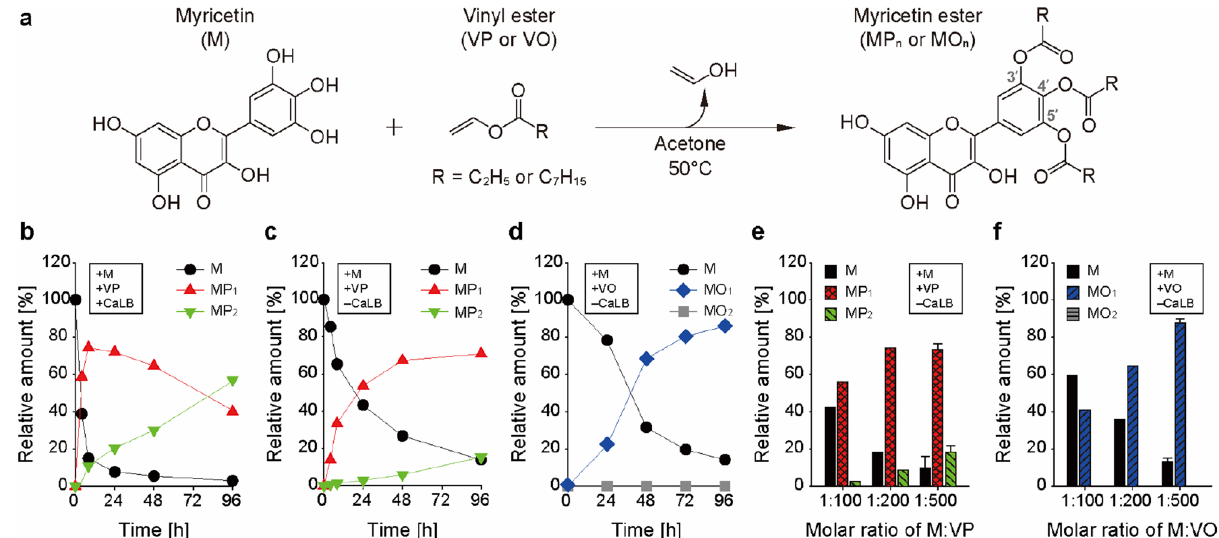
Figure 1. Synthesis of acyl myricetins in the presence and absence of an enzyme catalyst CaLB. ( a ) Schematic representation of acylation reaction of myricetin with vinyl ester [VP, vinyl propionate (R = C 2 H 5 ); VO, vinyl octanoate (R = C 7 H 15 )], resulting in acyl myricetins. The reactions were conducted by shaking with 700 rpm at 50 °C in acetone. Three carbon positions susceptible to acylation are indicated as gray color in myricetin ester structure. ( b – d ) Acylation profiles of myricetin. ( b ) Myricetin (0.3 mg·mL −1 ) was acylated at a molar ratio of 1:500 with VP in the presence of 20 mg·mL −1 CaLB. For spontaneous acylation in the absence of CaLB, VP ( c ) or VO ( d ) as an acyl group donor was used in a reaction adopting the same conditions as in ( b ). ( e , f ) Effects of molar ratio of myricetin-to-vinyl ester on acylation efficiency. The relative amounts of free, monoacyl-, and diacyl-myricetin were determined after propionylation ( e ) and octanoylation ( f ) in 96-h reaction without CaLB, depending on indicated molar ratio of myricetin and vinyl ester. Reactants used for each reaction are indicated ( b – f ). Data are expressed as the mean ± s.d ( e , f ). M, myricein; MP 1 , monopropionyl-myricetin; MP 2 , dipropionyl-myricetin; MO